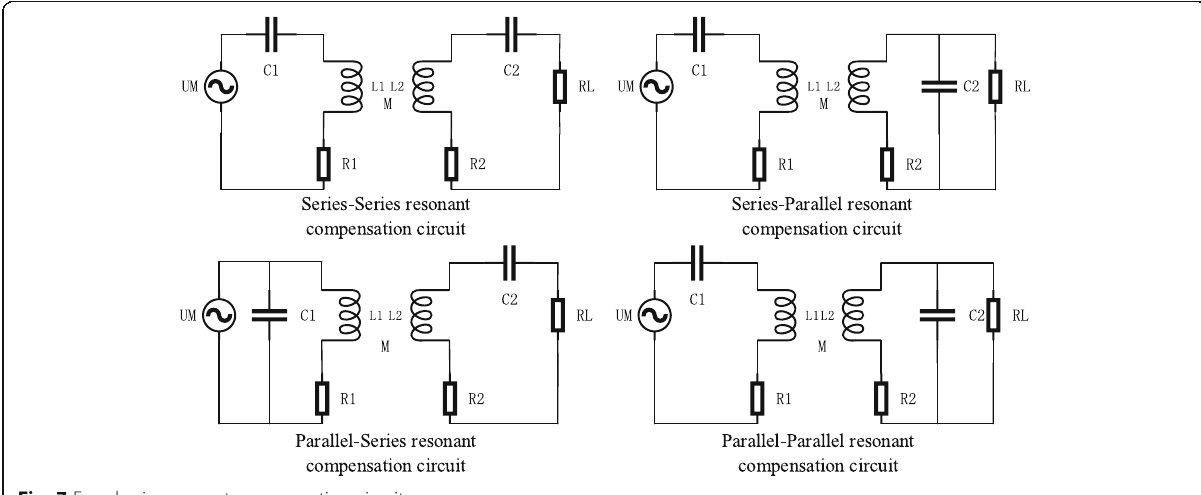
Fig. 7 Four basic resonant compensation